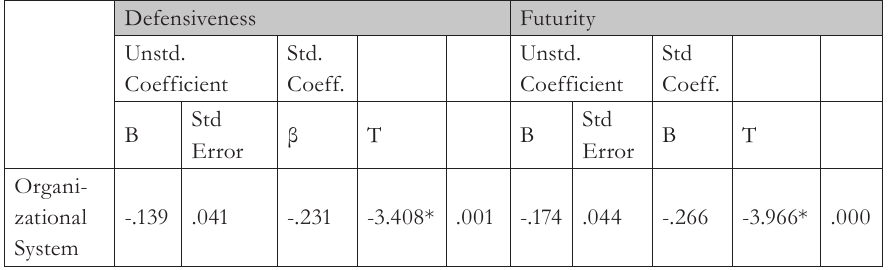
Tab. 5 - Impact of Organizational System, Top Management Factor, and Departmental Connec- tivity on Defensiveness and Futurity Dimensions. Source: Field